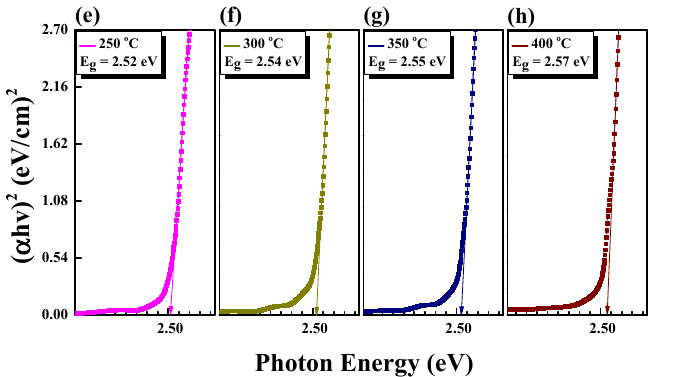
Figure 5. Optical energy band gaps of Cu 2 O thin films deposited in the substrate temperature range from 25 °C to 400 °C: ( a ) 25 °C, ( b ) 100 °C, ( c ) 150 °C, ( d ) 200 °C, ( e ) 250 °C, ( f ) 300 °C, ( g ) 350 °C, and ( h ) 400 °C.